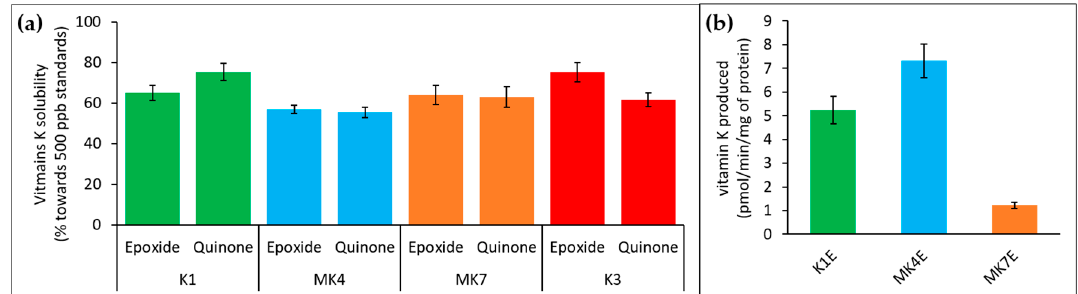
Figure A1. Vitamin K epoxide and quinone solubility in assay conditions and vitamin K epoxide reductase (VKOR) activity assays and kinetics towards 10-µM vitamins K E solutions. ( a ) Vitamin K1, MK4, MK7, and K3 epoxide and quinone solubility in 100-µM buffer solutions. Areas under the curve obtained from LC-MS standards were normalized for each vitamin K epoxide and quinone (100%) and used as references to evaluate solubility of vitamins K in our buffer solution. Solubility values are colored as green, blue, orange, and red for vitamins K1, MK4, MK7, and K3, respectively. Resulting solubility values ranked within the same range of values, from 55% for vitamin MK4 Q to 75% for vitamin K1 Q , and thus assessed the equivalent concentrations of vitamin K epoxide in our buffer solutions. ( b ) Specific vitamin K epoxide reductase activity towards vitamins K1 E or MK4 E . VKOR activity was evaluated in the presence of 10 µM of vitamins K E .